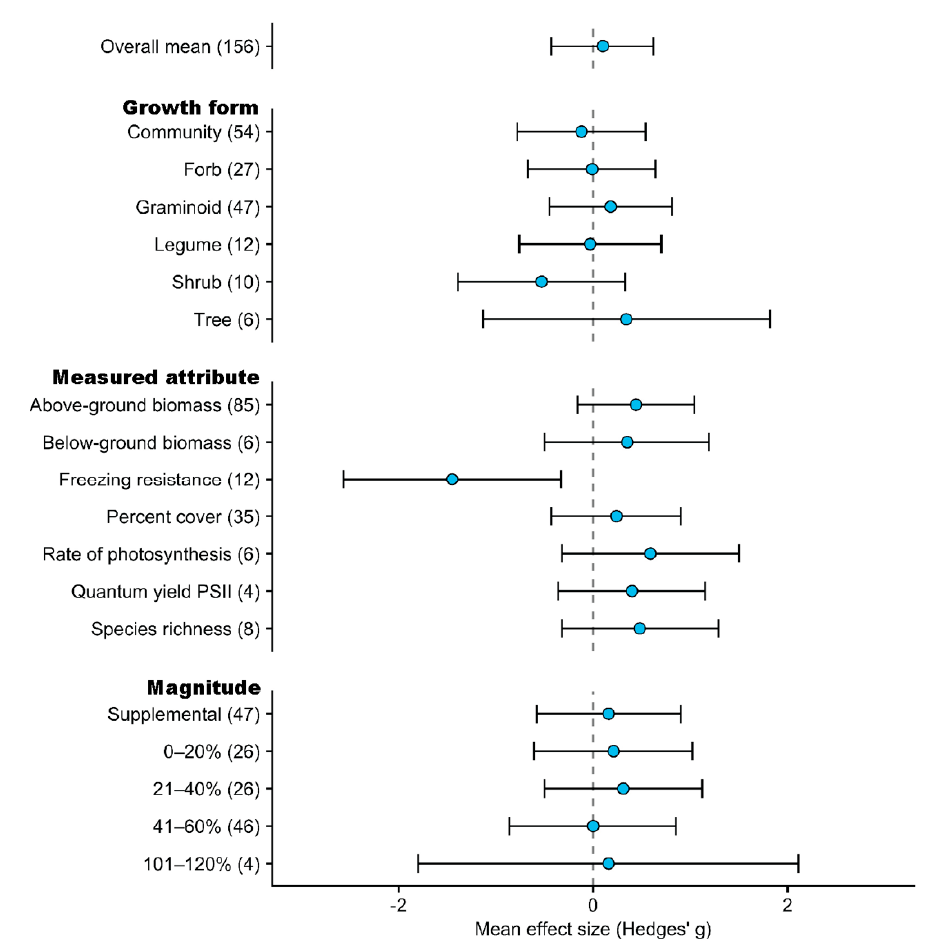
Figure 7. Mean effect sizes (Hedges’ g) and 95% confidence intervals for the effect of increases to water supply on high elevation plants according to growth form, response variable measured, and treatment magnitude. Sample sizes for each predictor variable are represented in parentheses. Only predictor variables with sample sizes equal to or greater than 4 are